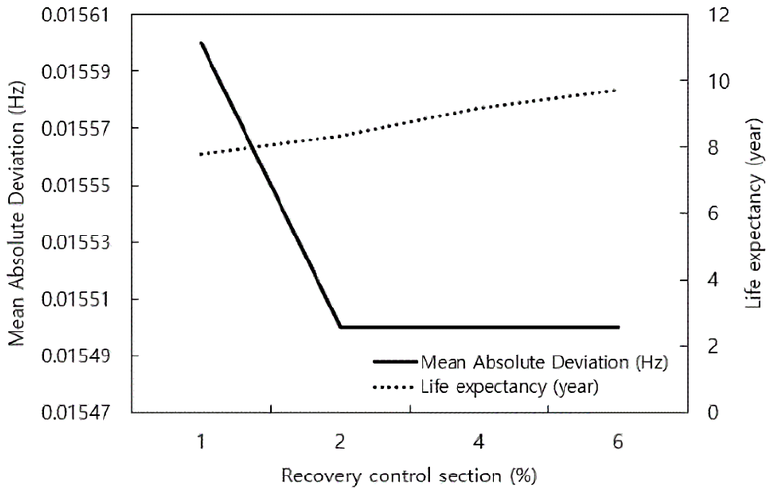
Figure 13. Performance and life evaluation according to SoC recovery range change.